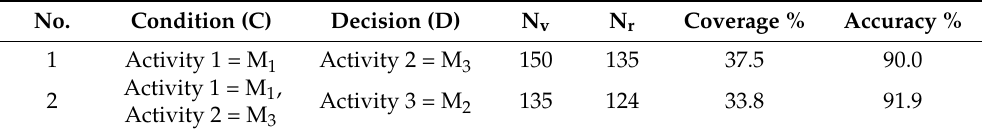
Table 11. Prediction results of testing data.